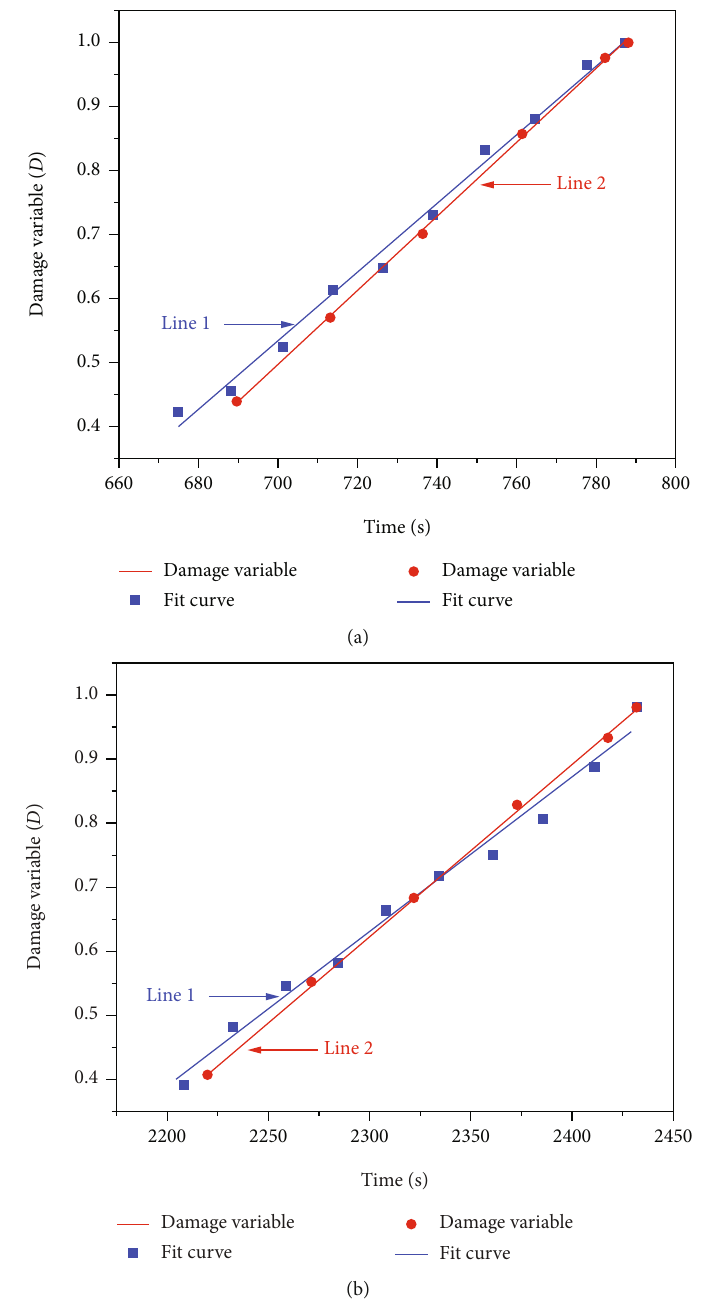
Figure 7: The damage fi tting curve by di ff erent methods. (a) The result of specimen R1. (b) The result of specimen